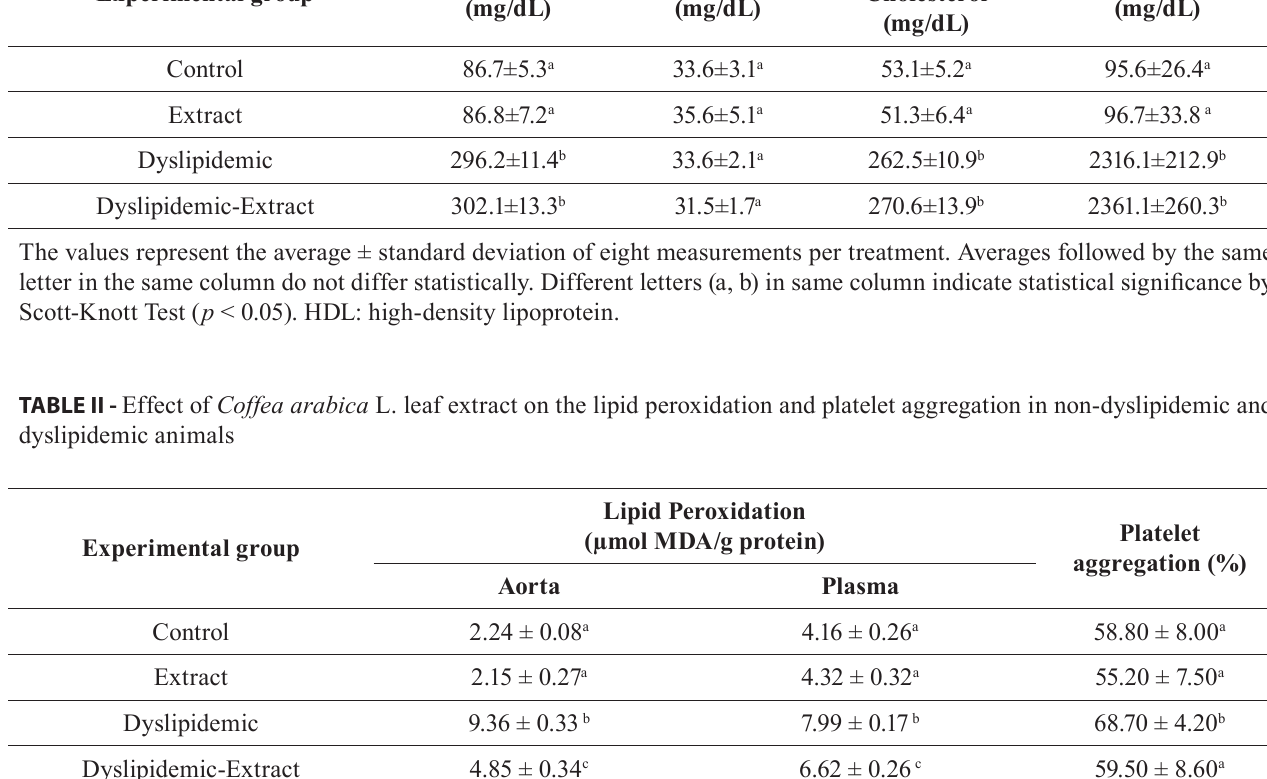
Experimental group